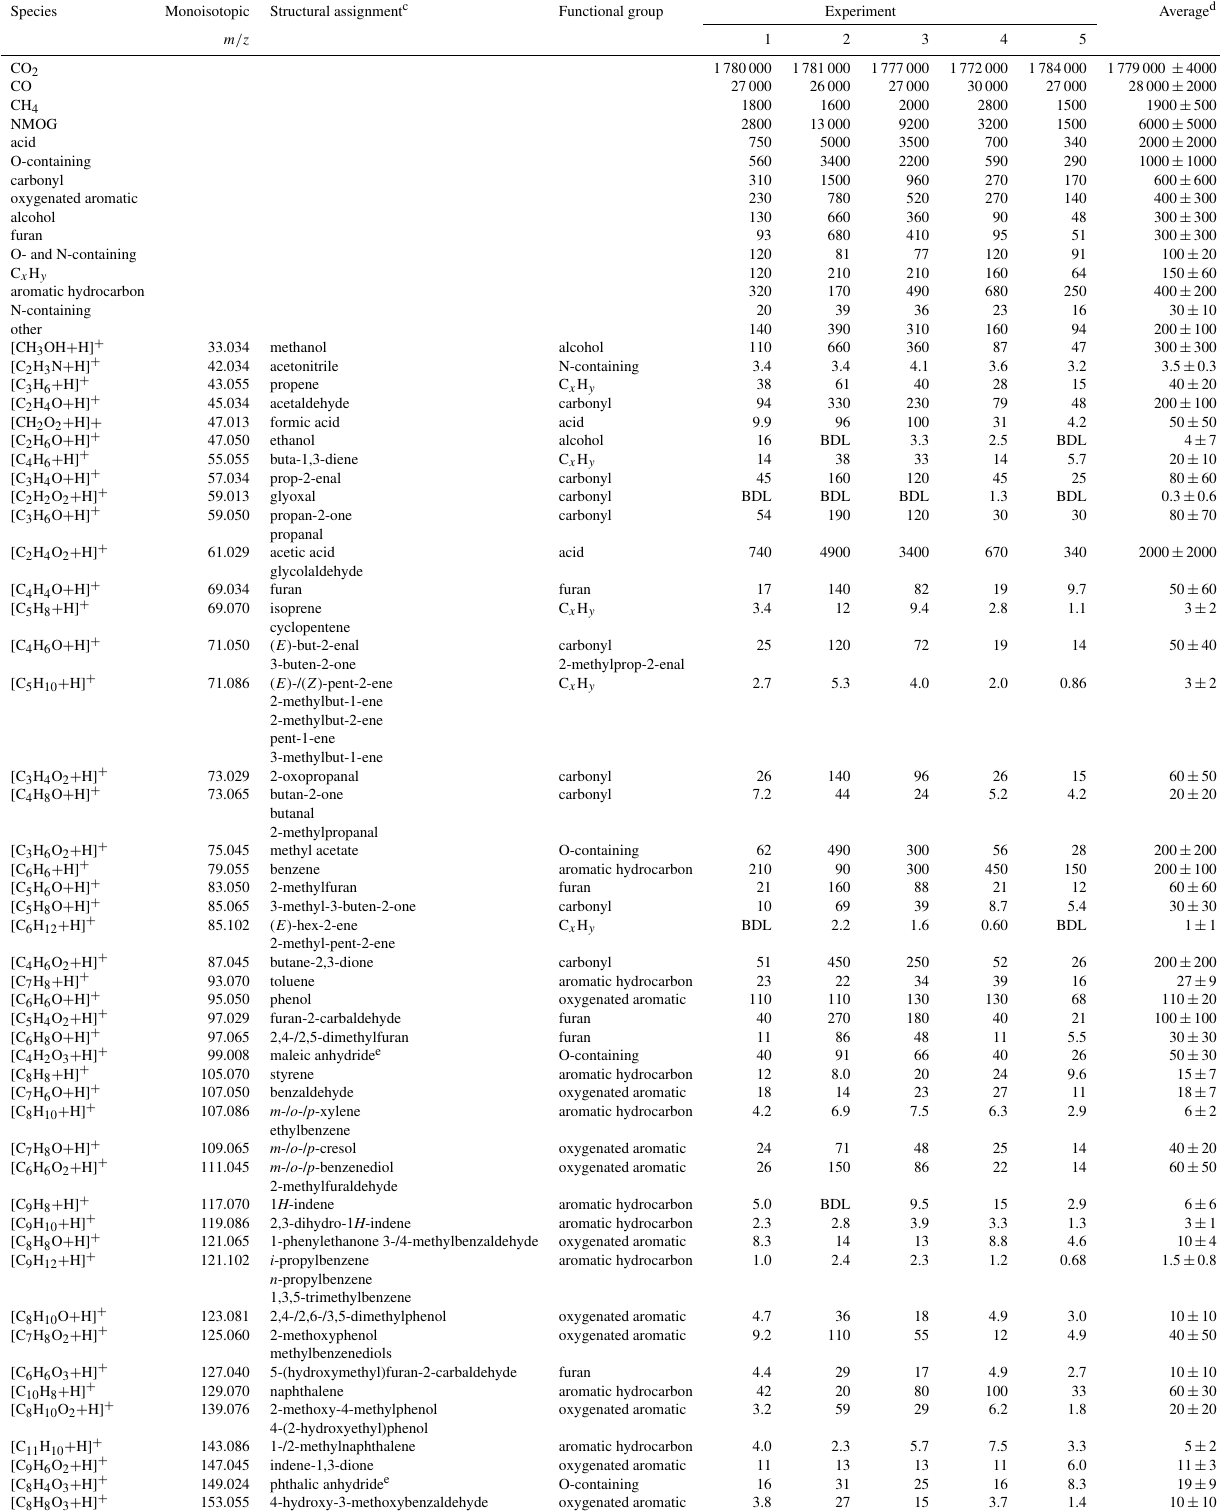
Table 2. Primary emission factors of gas-phase species (mgkg − 1 ) a, b .